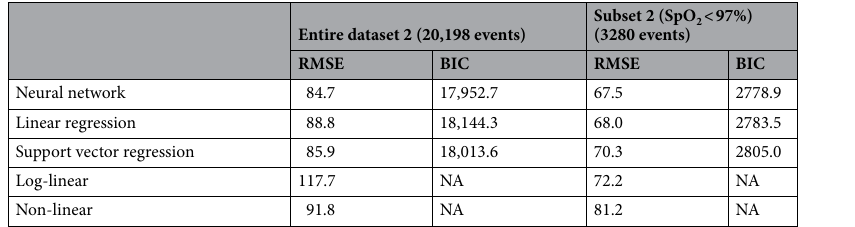
Table 3. RMSE and BIC of the 3-feature machine learning models regression tasks compared to published methods. The RMSE and BIC for the 3-feature machine learning models were calculated for the entire dataset (20,198 ICU events) and a subset of the dataset with SpO 2 < 97% (3280 ICU events) and compared to the published log-linear and non-linear models. BIC Bayesian information criterion, RMSE Root-mean-square deviation. RMSE: An estimate of the differences between values predicted by a model and the values observed. The lower RMSE is, the lower the difference that exists between the predicted and observed values. BIC: A criterion used in Bayesian statistics to choose between models. The model with the lowest BIC is supposed to be the best.